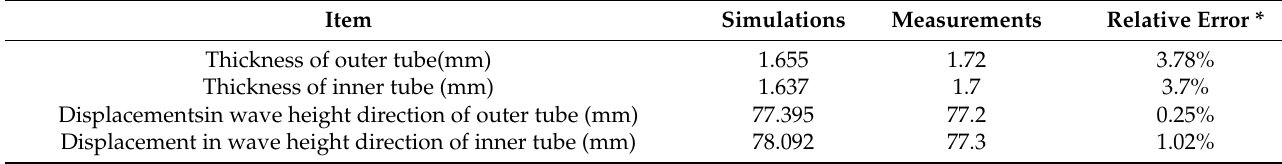
Table 4. Comparisons between simulation results and experimental results of the first wave.